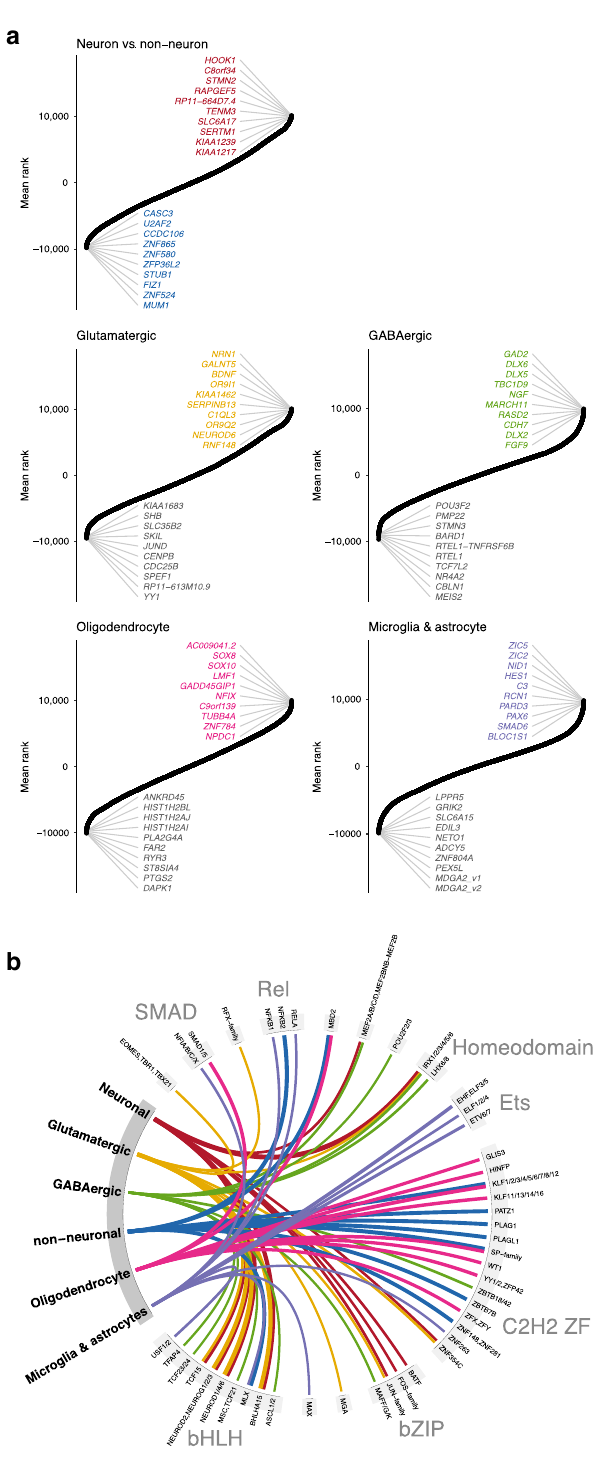
enhancer sequences for BDNF (GLU), DLX6 (GABA), CNDP1 (OLIG), and TYROBP (MGAS) transcripts.